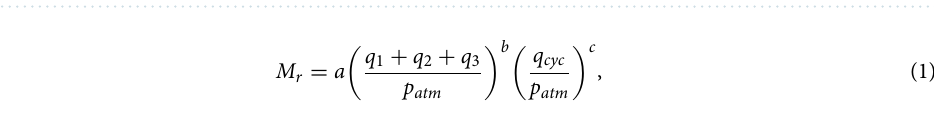
Figure 10. Variations in specimen height with w in different work conditions ( a ) focusing on freezing–thawing cyclic; ( b ) focusing on FC; ( c ) focusing on f cyc